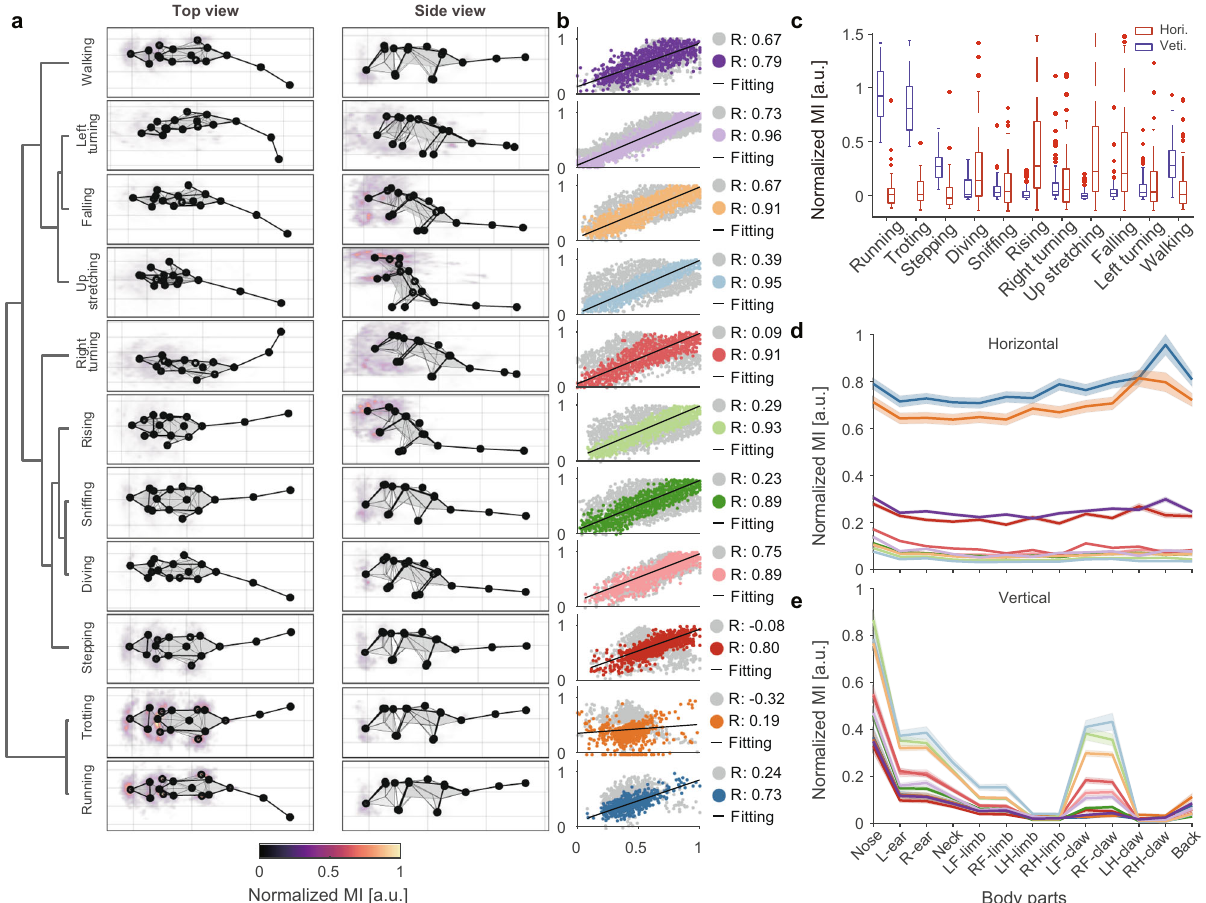
Fig. 5 Visualization and quanti fi cation of behavioral kinematics. a Average skeleton of all frames within each movement phenotype. The skeletons are shown with solid lines and calculated by averaging poses of body parts across time. The heatmaps overlaid on the average skeleton are the distribution and movement intensity (MI; see Supplementary Information for further details) corresponding to each movement phenotype. The MIs are scaled with 0 – 1 normalization method and shown in arbitrary unit (a.u.). b Correlation and linear regression plot of movement phenotypes. The horizontal axis represents the target, and the vertical axis represents the reference (see Supplementary Information for further details). The color-coded and gray dots correspond to the intra- and inter-cluster correlation coef fi cients, respectively. c The comparison of MI between different movement phenotypes. Each movement segment has two MI components (red boxes, horizontal; blue boxes, vertical). The boxes ’ values for each group contain the MIs of n behavioral modules ( n is the number of behavioral modules of each group). In box plots, the lower and upper edges of the box are the 25th and 75th percentiles of the MIs, the central marks indicate the median, the whiskers extend to the most extreme data points not considered outliers, and the outliers are plotted individually using the dot symbol. d , e Horizontal and vertical MI of each body part in different movement phenotypes. The values on each line are the MIs of all behavior modules corresponding to the phenotype, shown by body parts separately and presented as mean ± standard deviation (SD). Source data are provided as a Source Data fi